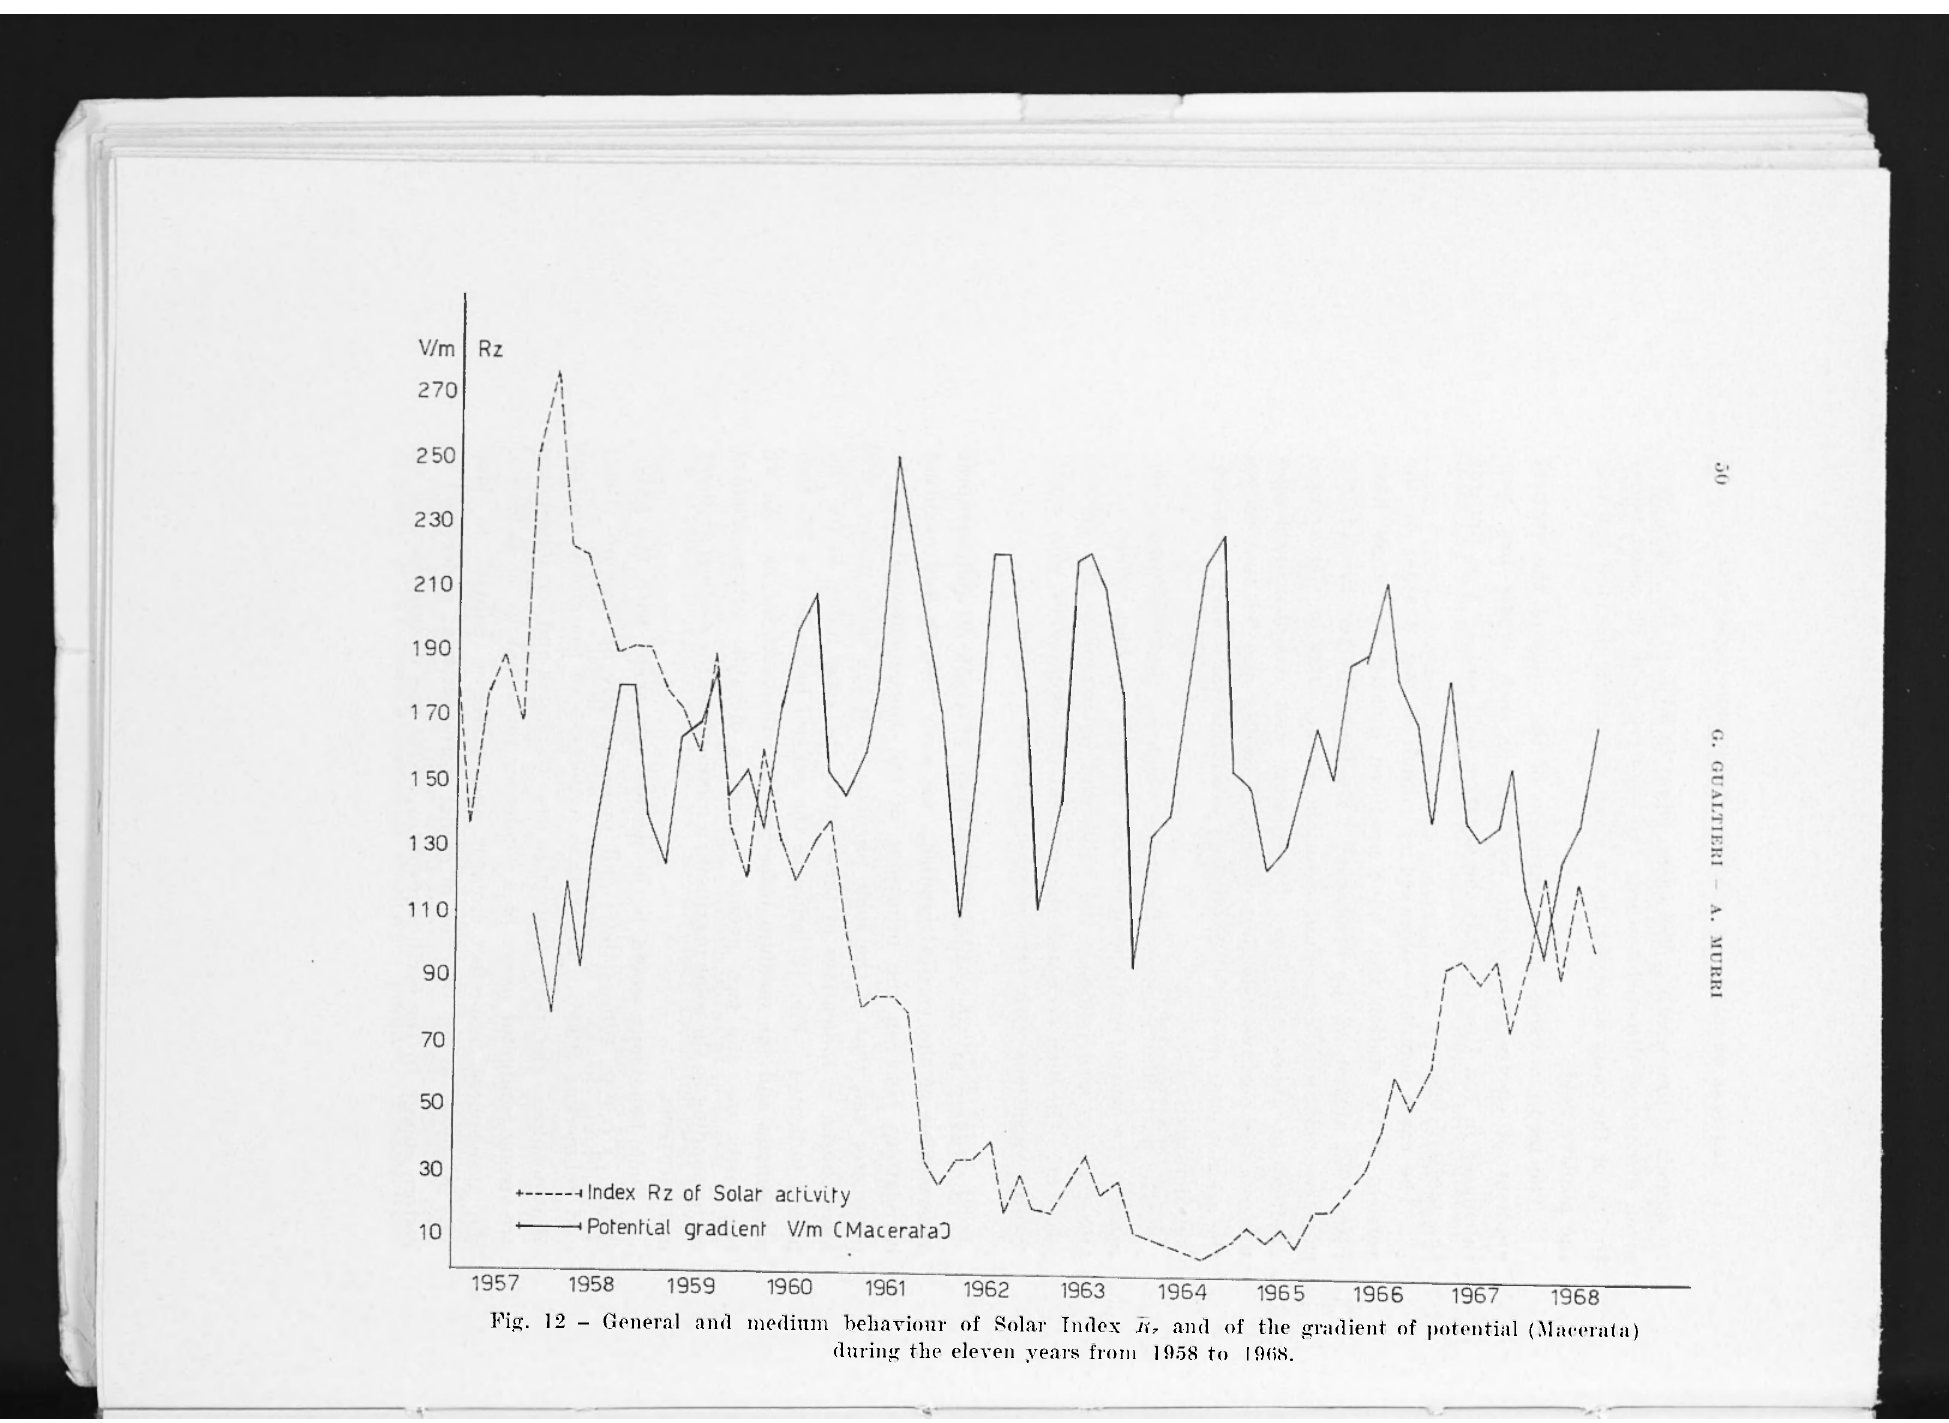
Fig. 12 - General and medium behaviour of Solar Index and of the gradient of potential (Macerata) during the eleven years from 1958 to